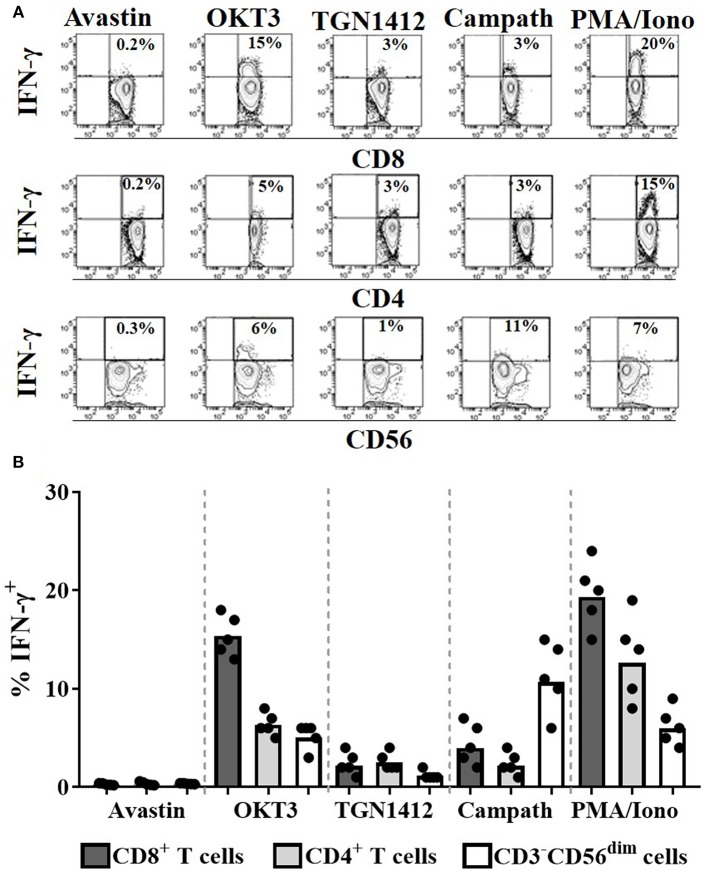
Cellular source of the IFN-γ in response to mAb stimulation. Intracellular IFN-γ staining of PBMCs stimulated for 24 h with Avastin, OKT3, TGN1412, Campath or PMA/Ionomycin (PMA/Iono). (A) Representative FACS contour plots of IFN-γ vs. CD8, CD4, or CD56 staining of PBMC cultures stimulated with the aforementioned treatments. (B) % CD8+ T cells, CD4+ T cells, and CD56dim NK cells that are IFN-γ+ post-stimulation (n = 5, bars represent group means).